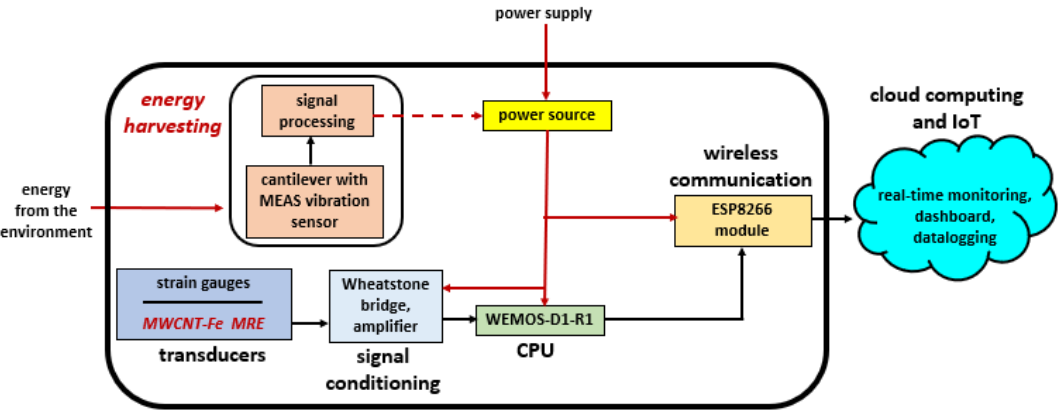
Figure 1. Schematic of the designed and implemented smart sensor. Red text—separately tested subsystems with preliminary